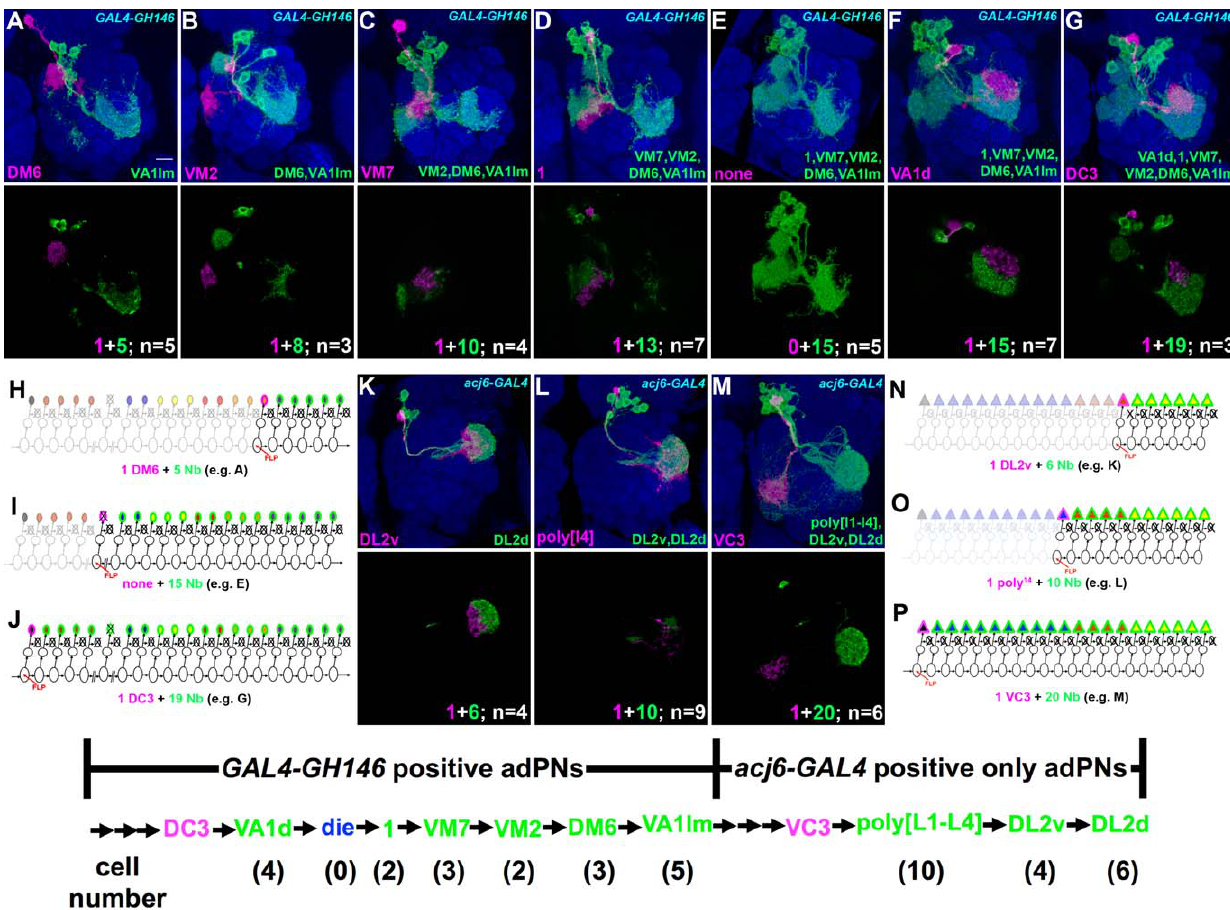
Figure 5. Distinct cell counts in different adPN types. Twin-spot clones labeled with GAL4-GH146 (A–G) or acj6-GAL4 (K–M). Upper panels: composite confocal images of sister clones in the AL; lower panels: single focal sections showing no innervation of the magenta glomeruli by the green NB clones, indicating clones derived during birth of the last sibling of the preceding adPN type. The clones shown in (A) and illustrated in (H) reveal the adPN NB makes five VA1lm-targeting PNs following derivation of the last DM6-targeting PN. Illustrations of lineage development for additional twin-spot clones are shown in (I), (J), and (N) to (P). Invariant cell counts were obtained for the majority of NB clones paired with the last sibling of the preceding adPN type (see Tables S3 and S4). These support production of a fixed number of neurons for each multi-cellular adPN type, as summarized in the bottom.